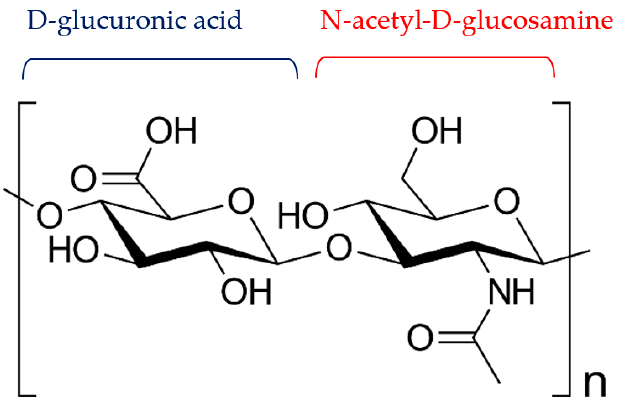
Figure 1. Hyaluronic acid (HA) molecule representation. The two dimers N-acetyl-D-glucosamine and D-glucuronic acid are highlighted.